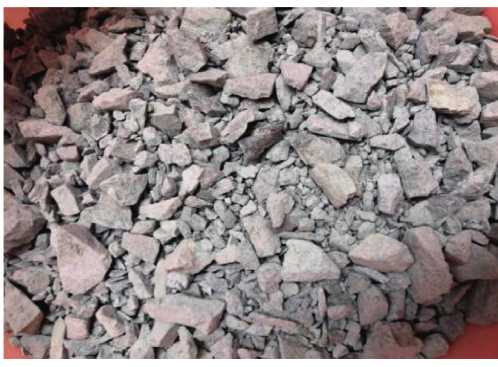
Figure 1: A sample of coal zircon. Table 1: Determination results of particle size composition of coal